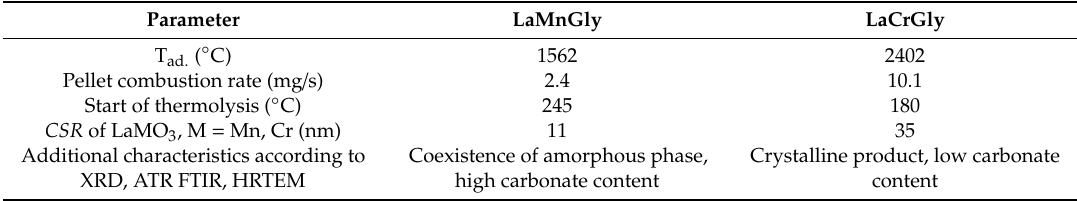
Table 4. Comparison of SHS combustion of LaMnGly and LaCrGly precursors.